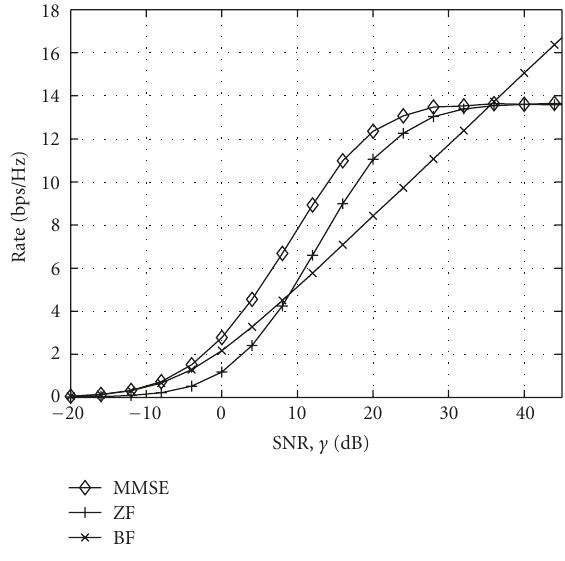
Figure 6: Simulation results for BF, ZF and MMSE systems with delay, N t = U = 4, f d T s = 0 .